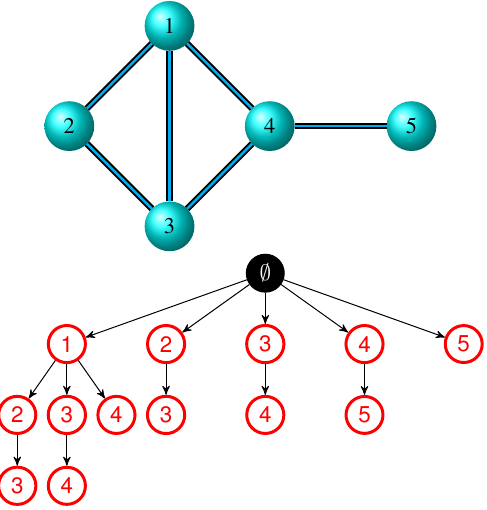
Figure 3: A simple graph (top) and its clique tree (bottom). Each red node t corresponds to the clique of the graph de- k fined by listing the nodes n i from ∅ to t